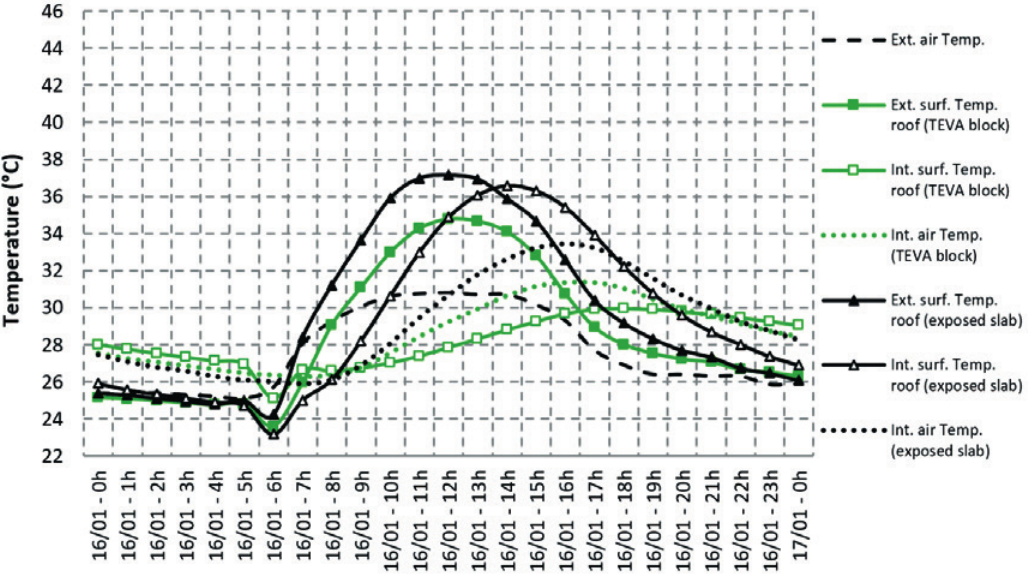
Thermal behavior of the prototype with green roof with TEVA blocks over the slab and of the prototype with exposed slab, on the typical summer day